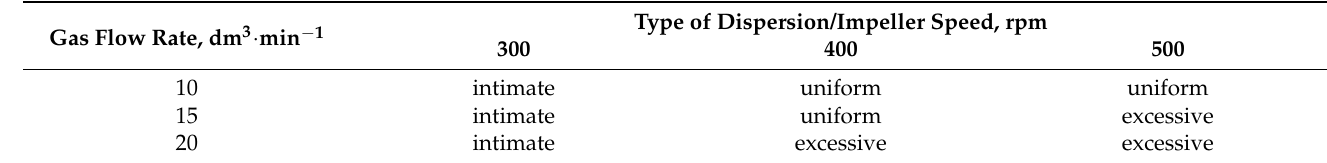
Table 3. Summary of visualization results—different types of gas bubble